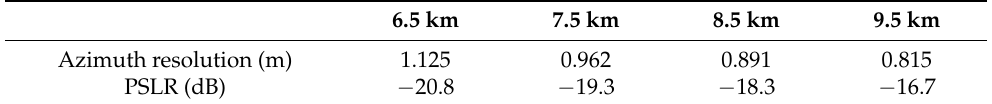
Figure 22. Azimuth profile with respect to the various baselines: 6.5 km ( a ), 7.5 km ( b ), 8.5 km ( c ), 9.5 km ( d ). Table 8. Azimuth resolution and PSLR with respect to the baseline.